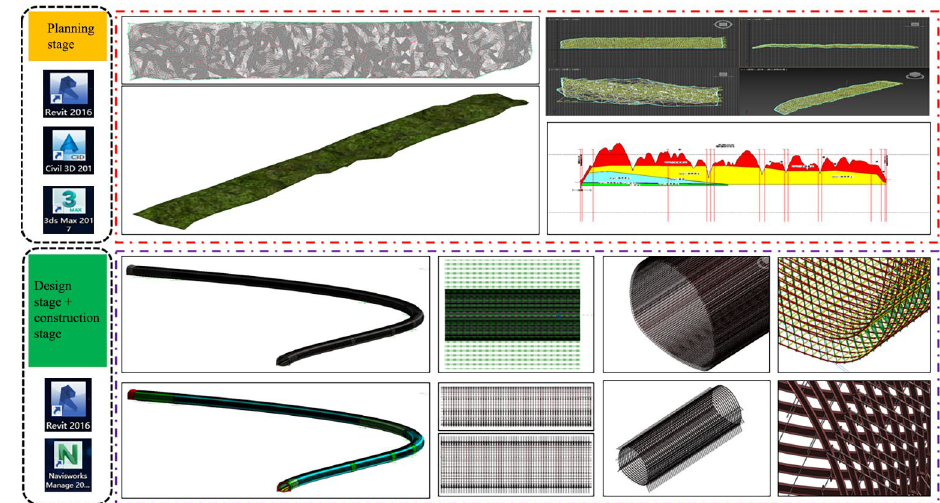
Figure 5. Diagram of BIM technology application in Tunnel 1 of Huanxian